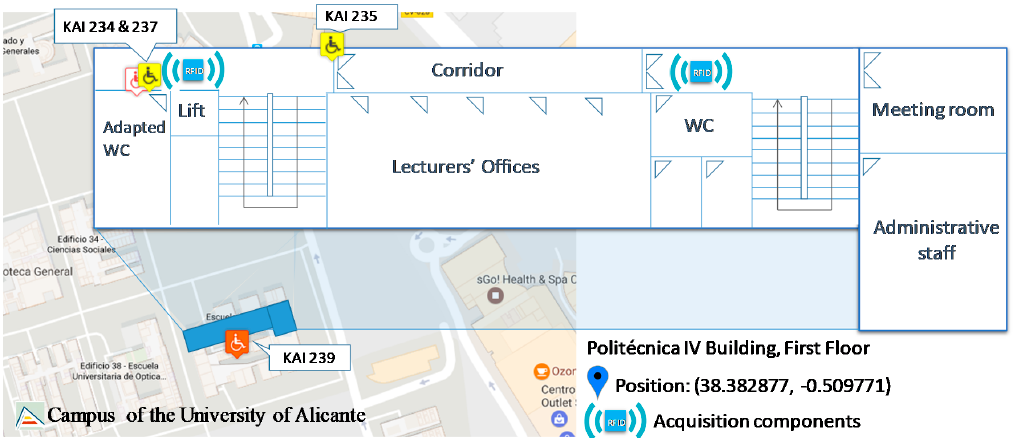
Figure 14. Indoor scenario and RFID-based acquisition components deployed.